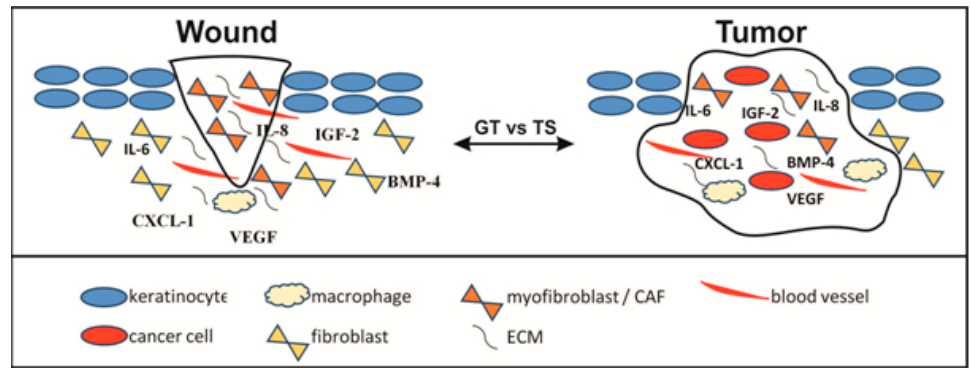
Figure 1. Schematic comparison of wound/tumor microenvironment created by cells located in the granulation tissue/tumor stroma (GT/TS), respectively (interleukin 6/8 (IL-6/-8); insulin-like growth factor 2 (IGF-2); bone morphogenic protein 4 (MBP4); chemokine (C-X-C motif) ligand 1 (CXCL1).